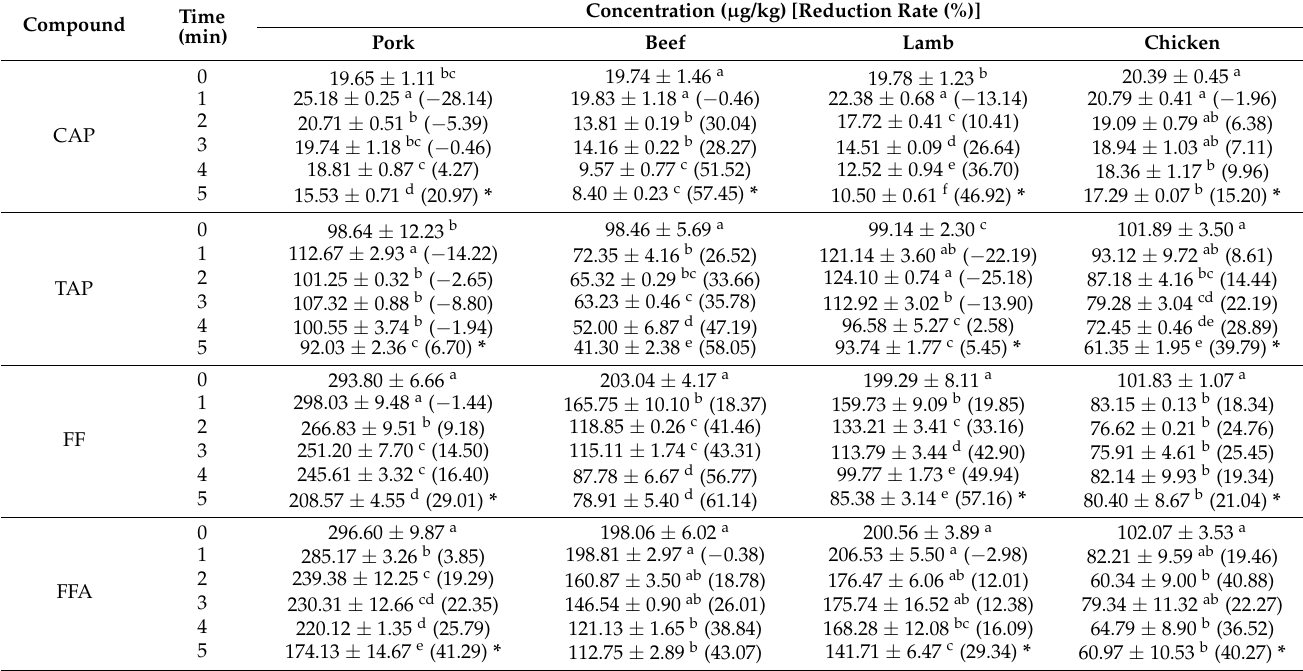
Table 6. Effect of deep-frying time on residues of amphenicols and metabolites in livestock and poultry